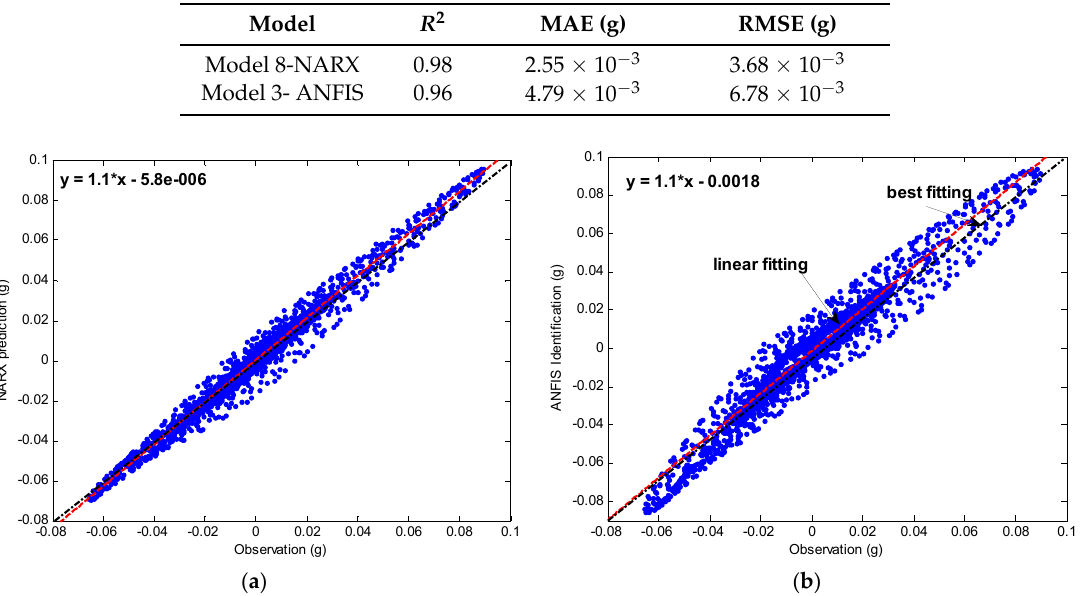
Figure 10. TMD ‐ 2.39 testing the capability of response prediction by two models: ( a ) model 8 ‐ NARX; Figure 10. TMD-2.39 testing the capability of response prediction by two models: ( a ) model 8-NARX; and ( b ) model 3 ‐ ANFIS models. and ( b ) model 3-ANFIS